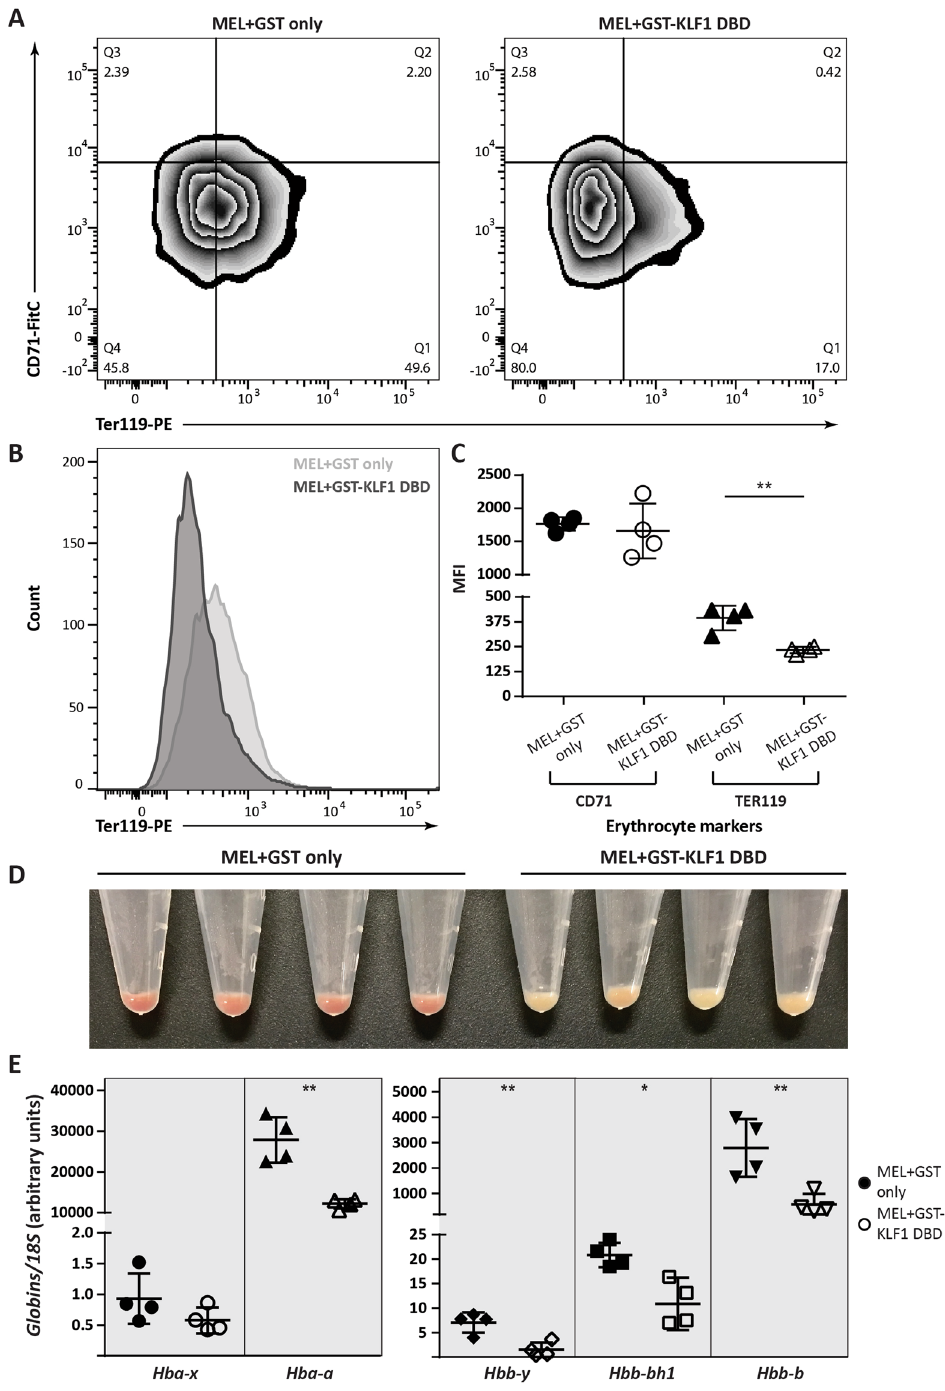
Figure 2. MEL cells overexpressing GST-KLF1 DBD display a less pronounced erythrocyte phenotype. ( A ) Representative flow cytometry plots of MEL + GST and MEL + GST-KLF1 DBD cells stained with antibodies against CD71 and TER119. ( B ) Histogram of flow cytometry for TER119 in a representative GST and GST- KLF1 DBD clone. ( C ) Statistical analysis of flow cytometry data for erythrocyte markers from all clones ( D ) MEL clones induced with DMSO. ( E ) Absolute levels of globin expression were analysed by qPCR in MEL + GST expressing clones compared to MEL + GST-KLF1 DBD expressing clones induced with DMSO. Expression levels were normalised to 18S rRNA. n = 4 for each construct. Error bars shown represent standard error of the mean, p values indicate the difference between the means, * p < 0.05, ** p < 0.01 (paired Student’s two-tailed t